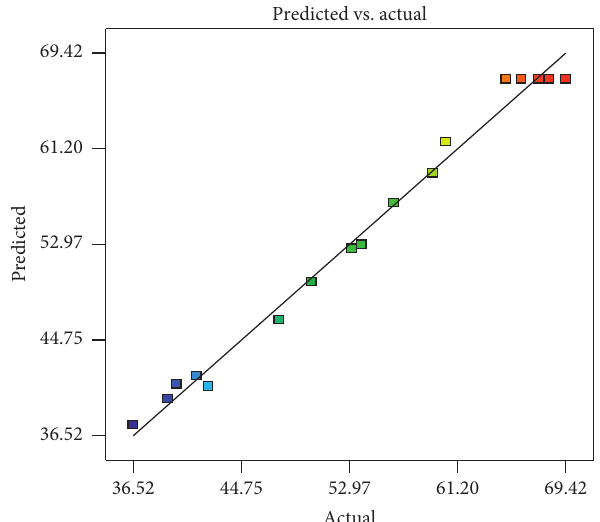
Figure 2: Relationship between the observed and predicted values of the degree of graft (Parity